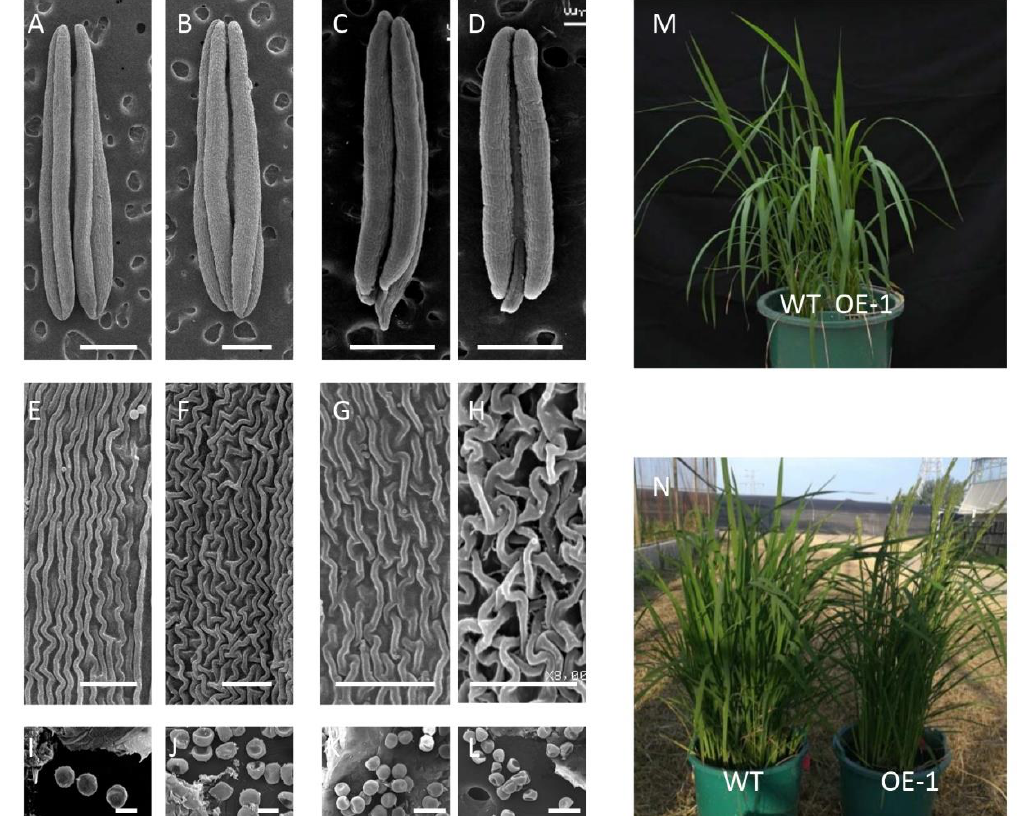
Figure 2. SEM observations of the mature pollen and phenotypes of transgenic rice plants. ( A ) Anthers of XN1376. ( B ) Anthers of XN1376-CIMS. ( C ) Anthers of wild-type Nipponbare. ( D ) Anthers of transgenic TaICK1 rice plants. ( E ) The outer epidermal cells of XN1376. ( F ) The outer epidermal cells of XN1376-CIMS. ( G ) The outer epidermal cells of wild-type Nipponbare. ( H ) The outer epidermal cells of transgenic TaICK1 rice plants. ( I ) The microspores of XN1376. ( J ) The microspores of XN1376-CIMS. ( K ) The microspores of wild-type Nipponbare. ( L ) The microspores of transgenic TaICK1 rice plants. ( M ) The phenotype of 35S::TaICK1 overexpression plants in young